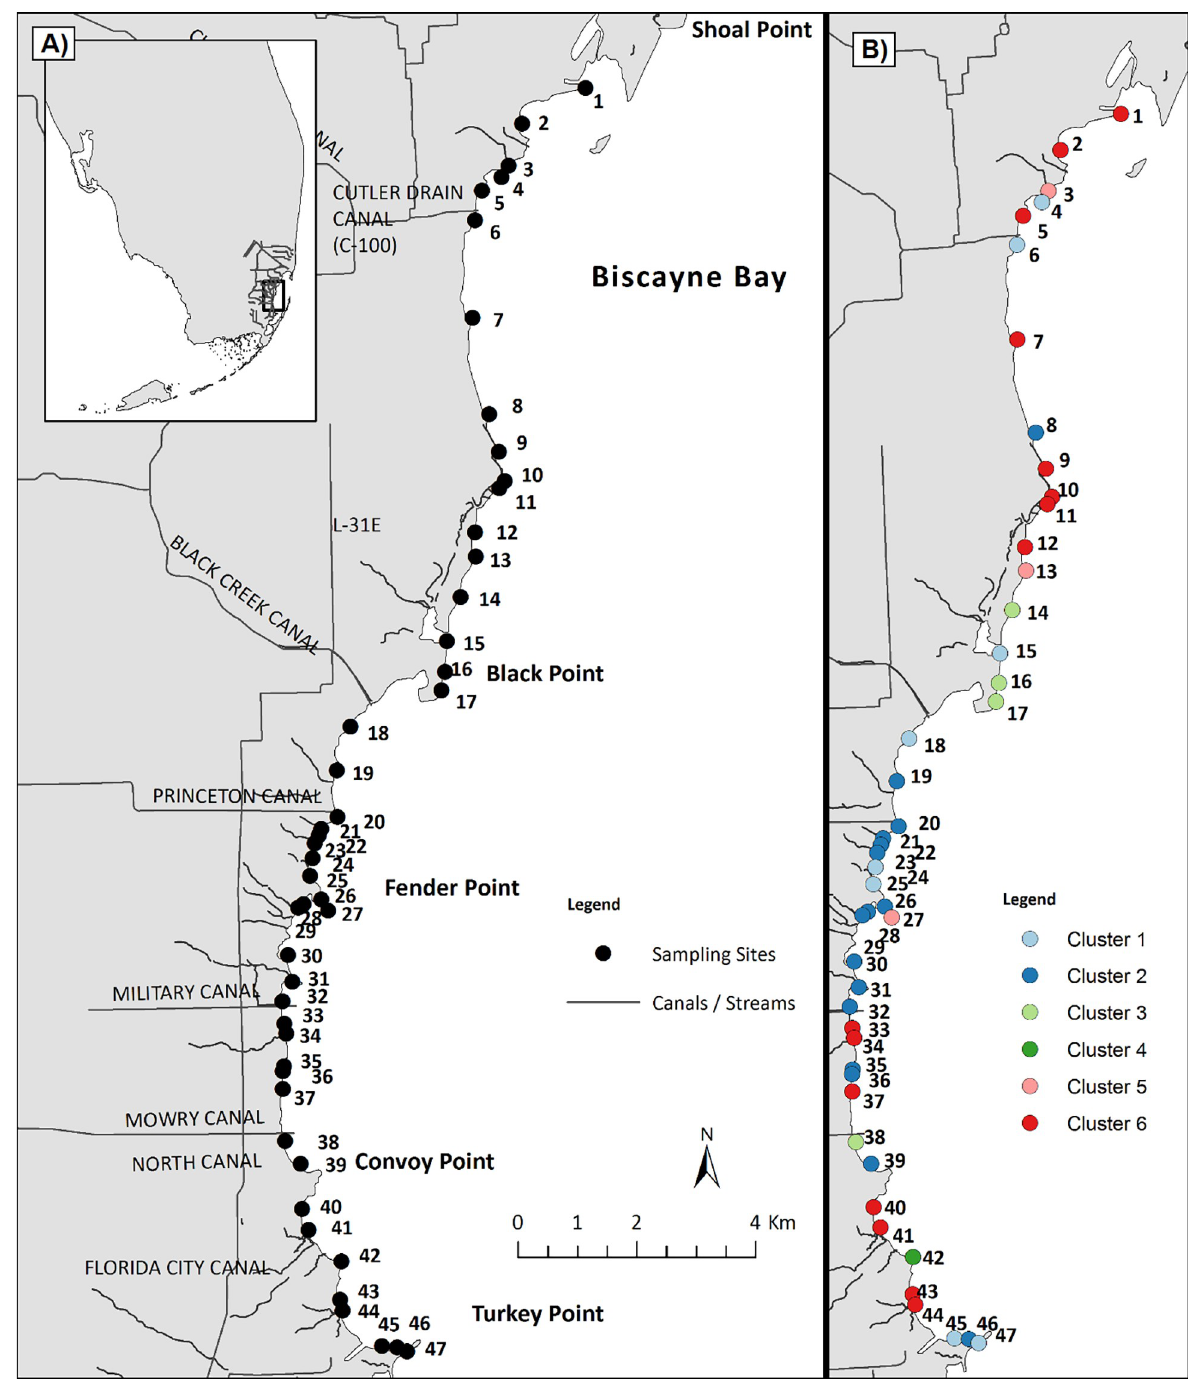
Fig 1. Map of study area, including referenced geographical features, and location of survey sites. The second panel depicts the same sites color- coded to match significant site clusters (Figs 2B and 4). Cluster 6 (red) exhibited similar spatial density patterns that were, on average, significantly higher than all other cluster groups. Conversely, Cluster 1 (light blue) exhibited significant, consistently lower densities than all other groups except for Cluster 4 (dark green). Clusters 2–5 exhibited intermediate average densities (Fig 4).